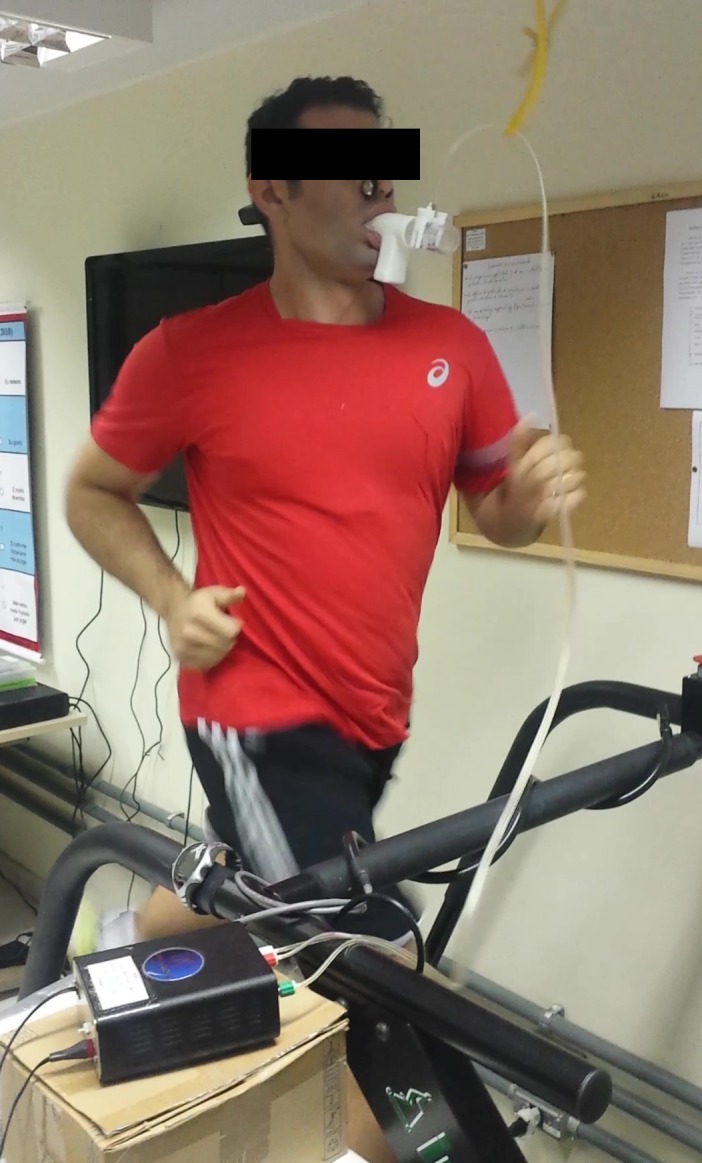
Maximal graded exercise testing session.Photo credit: Ricardo B. Viana.